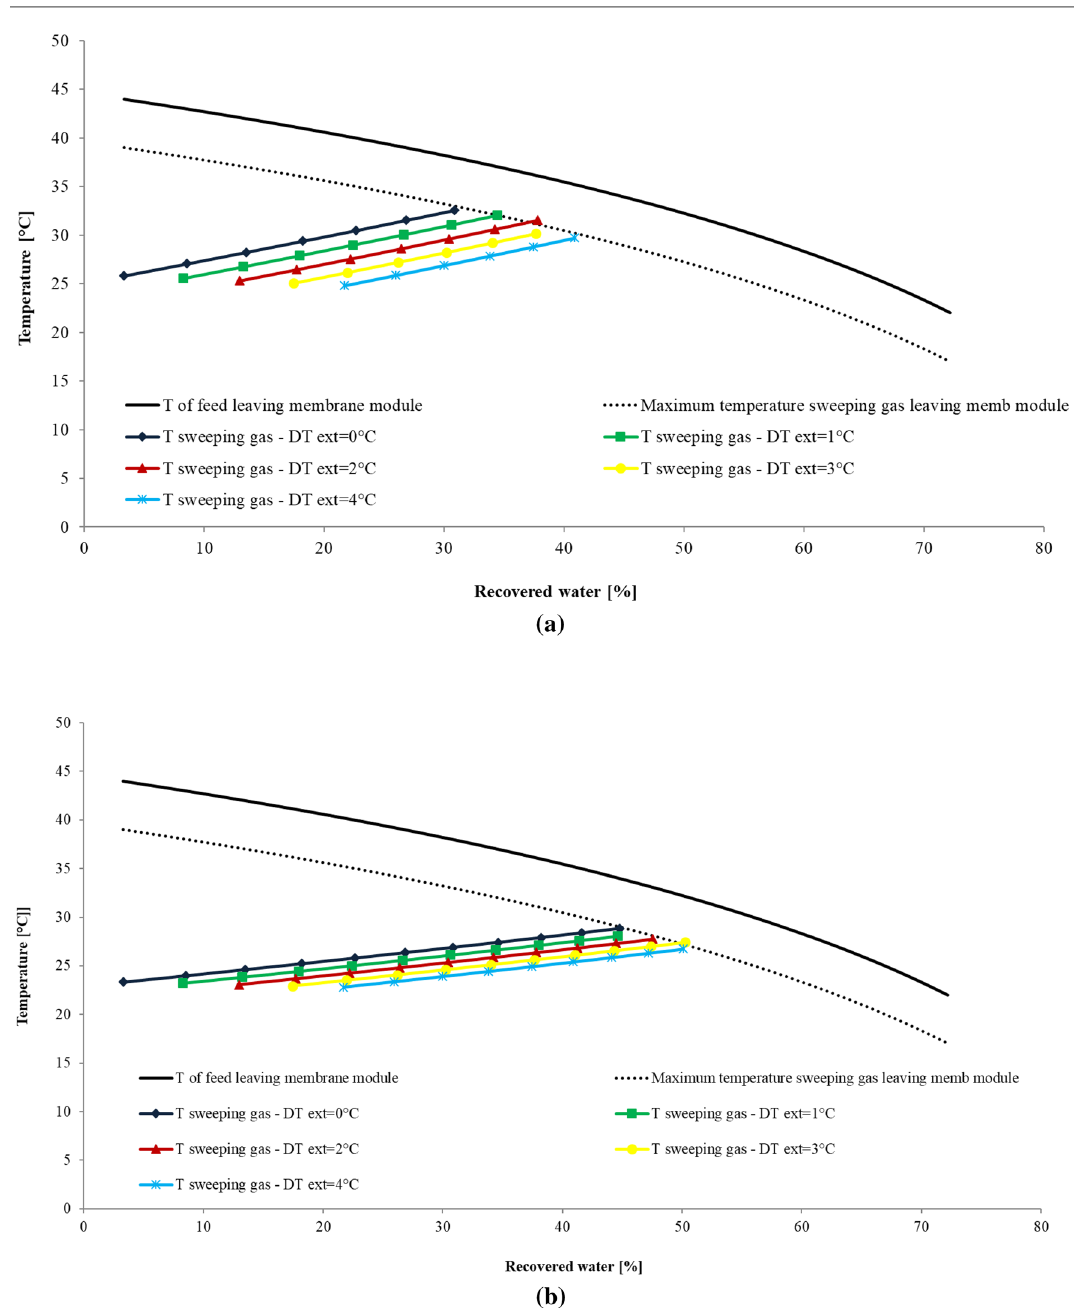
Fig. 10 Temperature versus recovered water in configuration 3 at increasing ΔT I = 5; b I = 10. Feed temperature = 45 °C; RH feed =